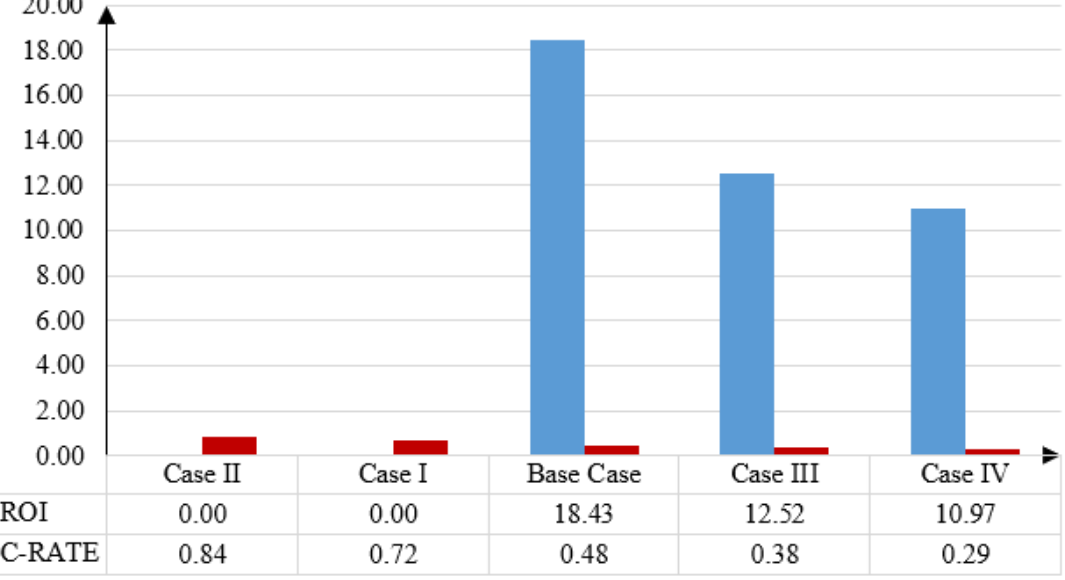
Figure 12. The results of C-rate sensitivity case study in terms of ROI (Return On Investment).